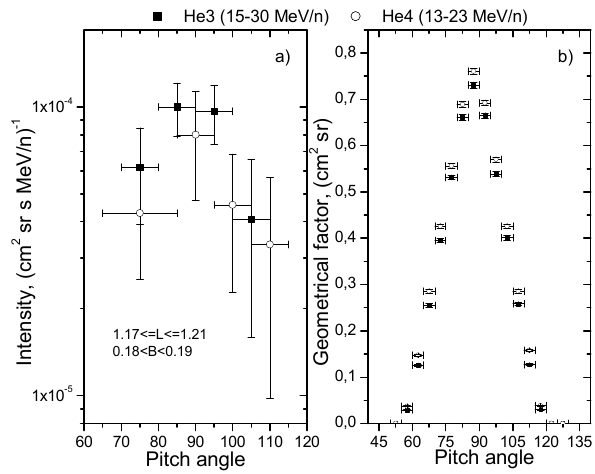
Fig.5. Fig. 5. (a) Pitch angle distributions of trapped 3 He (solid squares) and 4 He (open circles) isotopes in energy ranges 15–30MeV/n and 13–23MeV/n, correspondingly, for 1.17–1.21 L-bin and 0.18–0.19 B-bin. (b) Special NINA 3 He (solid squares) and 4 He (open circles) instrument geometrical factors as a function of particle pitch angle for orientation angle γ =87.5 ◦ , which were used to reconstruct the pitch angle distributions.